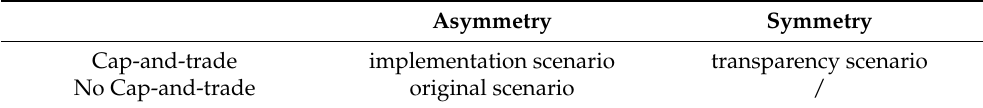
Table 2. The three